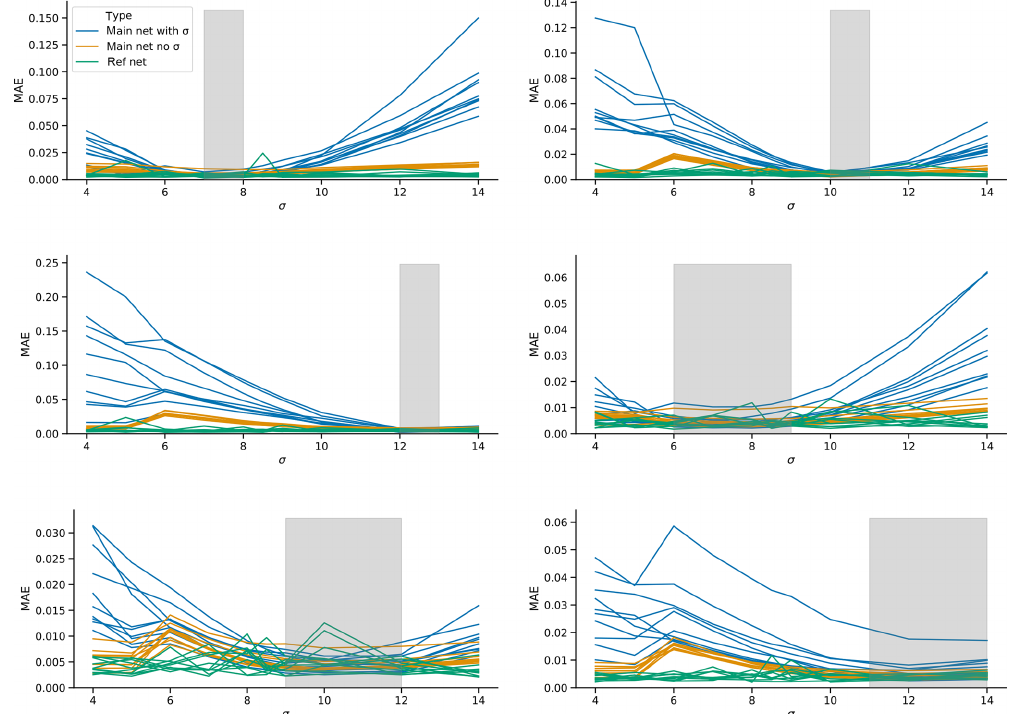
Figure 7. Short-term forecast errors for “forcing” experiments with Lorenz63. Networks are trained on a run with 1 × 10 5 time steps with a linearly increasing parameter σ from the lower to upper ends of the grey shaded area in the panels and then tested on runs with fixed σ . The blue lines show the errors for networks that include σ as input. The yellow lines show the networks without σ as input (“no input” networks in the text). The green lines show reference networks without σ as input that are trained on runs with σ fixed to the same value as the test runs (“fixed σ ” networks in the